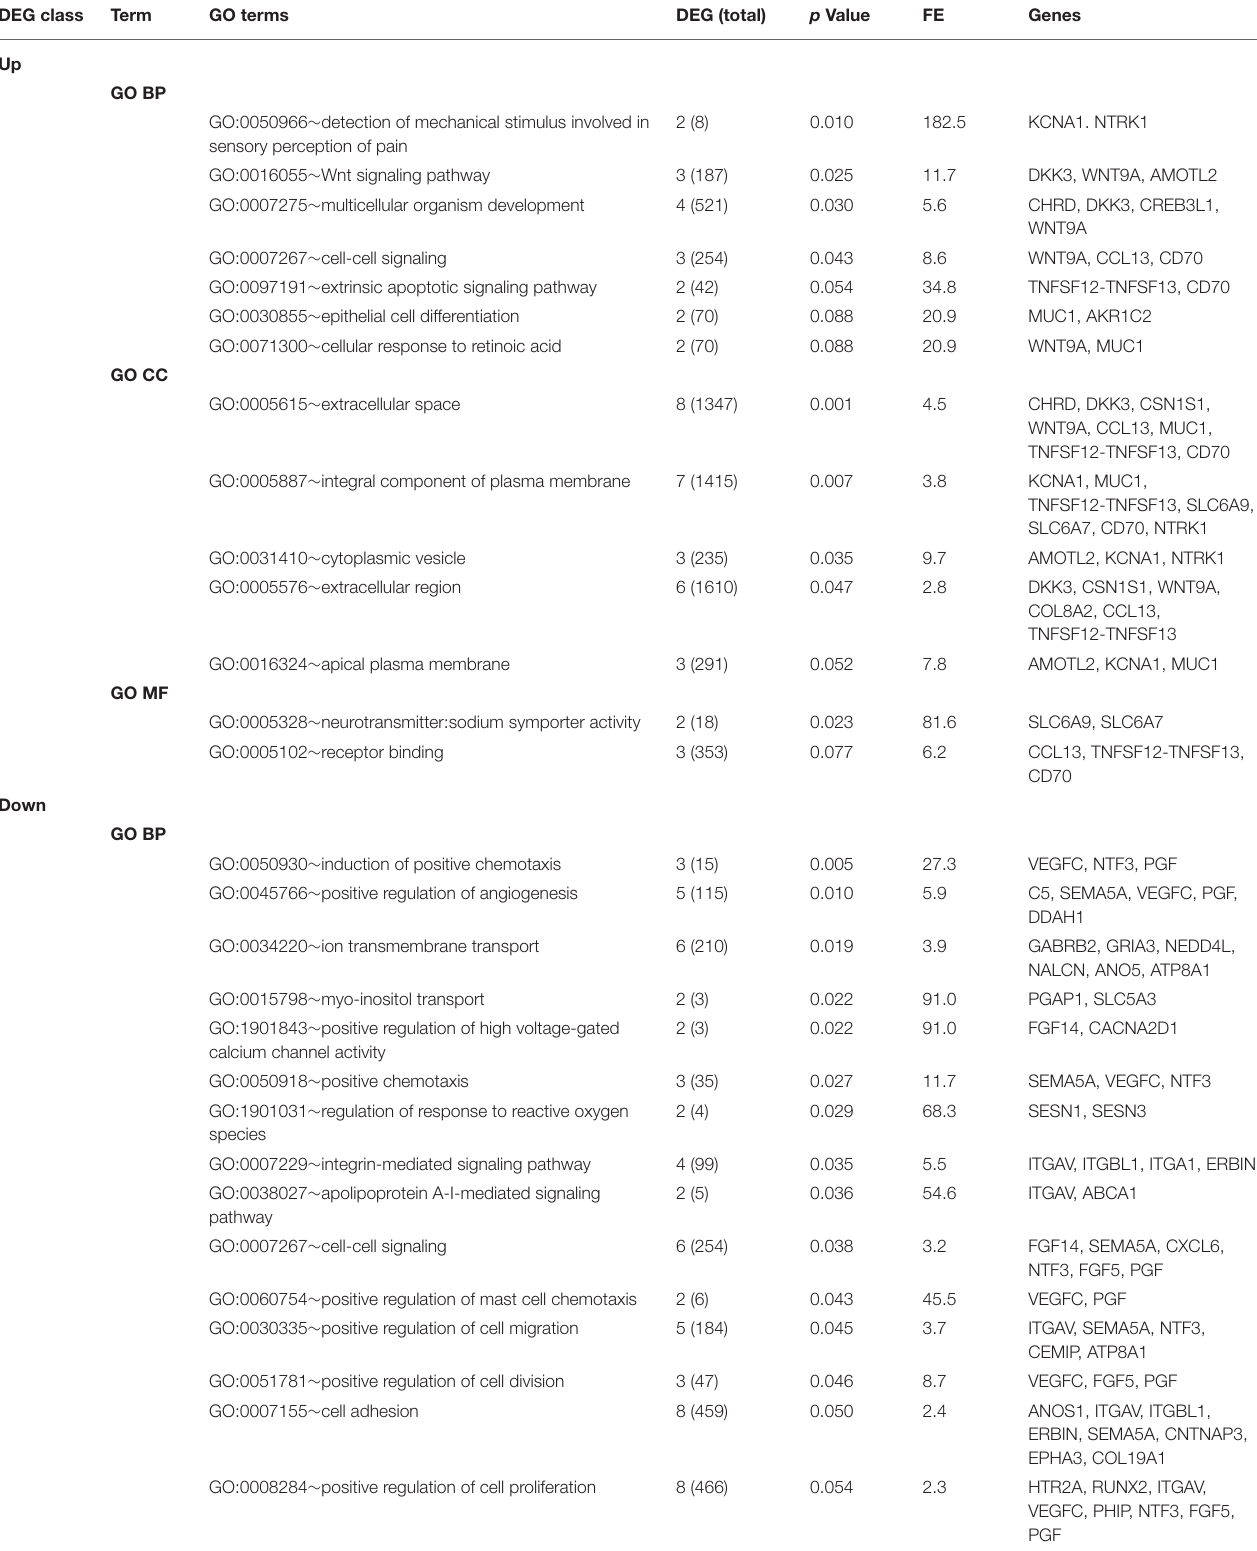
TABLE 2 | Gene ontology and KEGG pathway enrichment analysis of differentially expressed genes upon IL12p40/IL23p40 blockade with ustekinumab. DEG